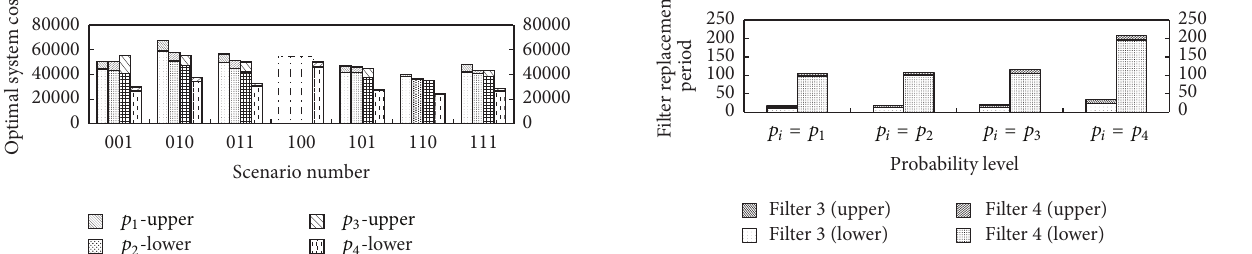
Figure 6: Filter replacement periods for Scenario 1 under high contaminant ingression/generation level.